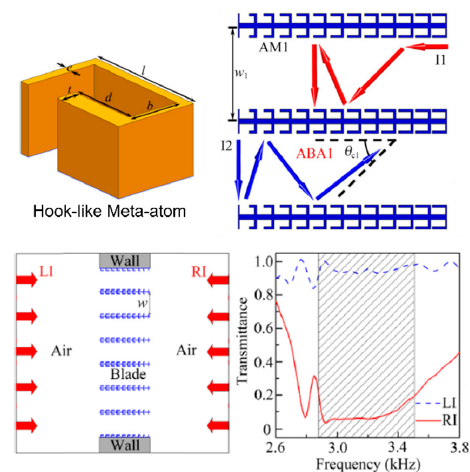
Figure 8. ( a ) Schematics of a hook-like meta-atom, acoustic propagation paths through the open windows with left incidence LI and right incidence RI, and corresponding transmission spectra. Reprinted Society,